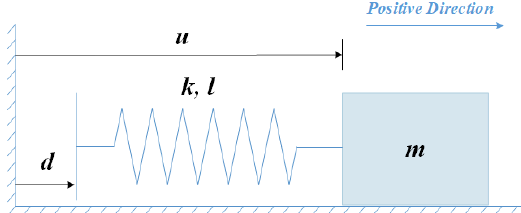
Figure 7. Spring–mass system.